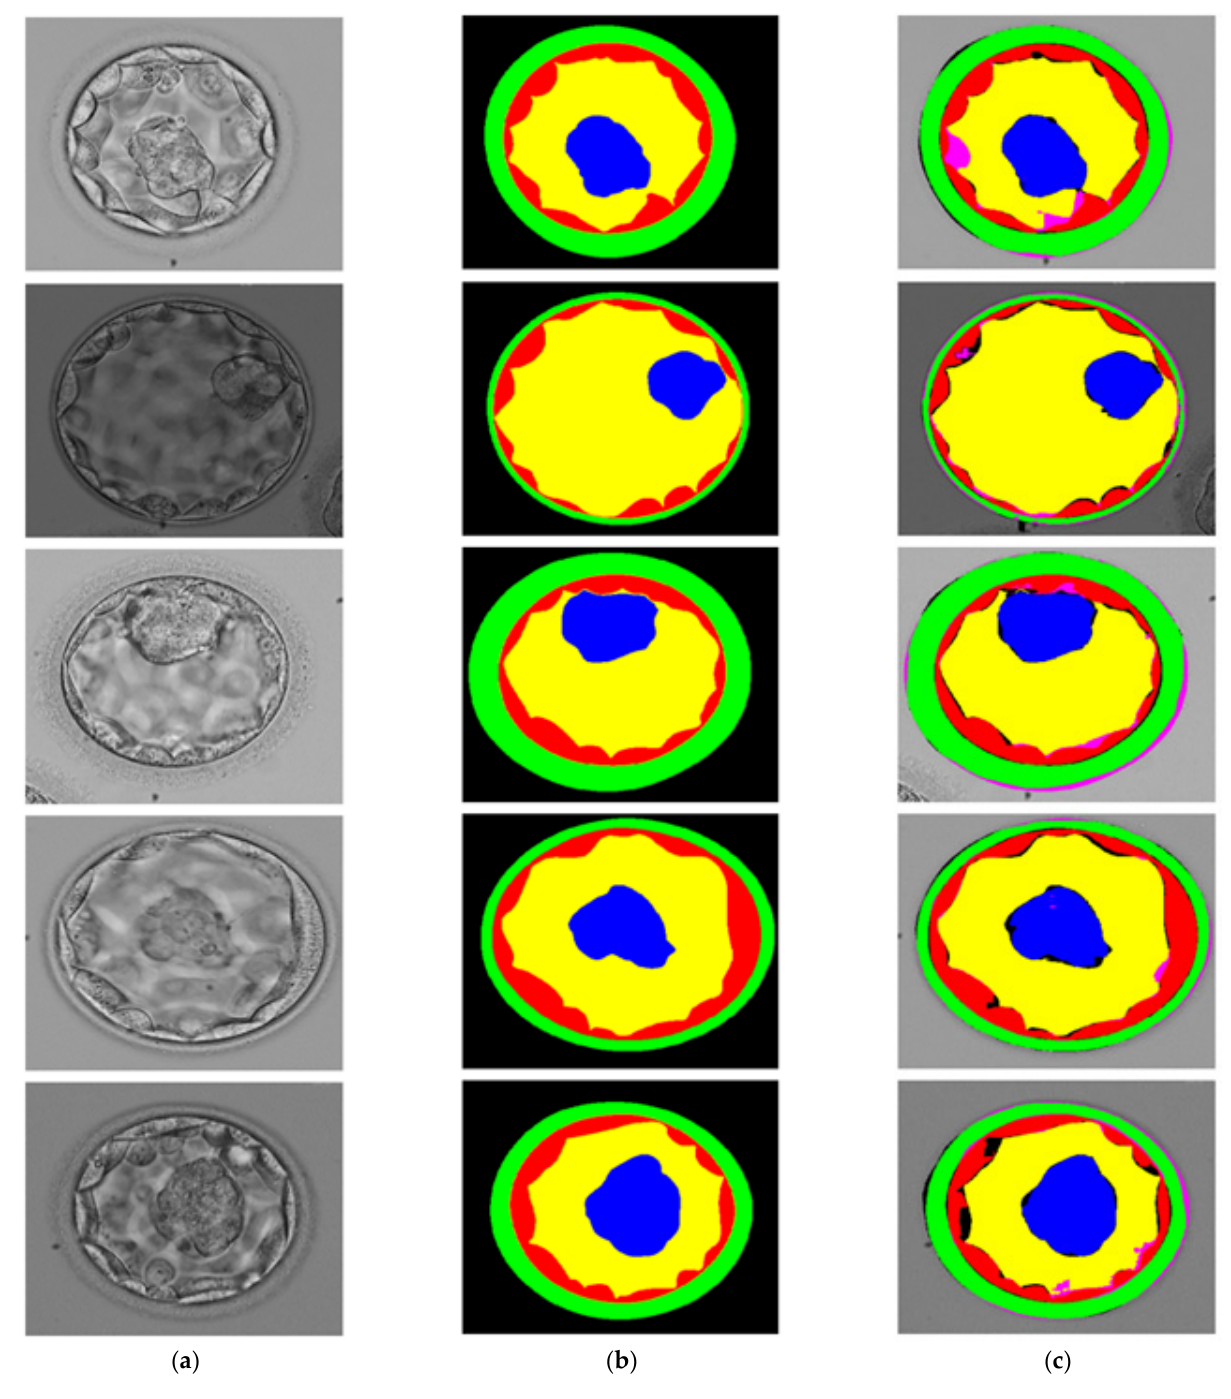
Figure 6. Visual Results of Proposed SSS-Net for blastocyst component detection: ( a ) Original Input Image, ( b ) Expert Annotation, and ( c ) Predicted Image Mask by SSS-Net.